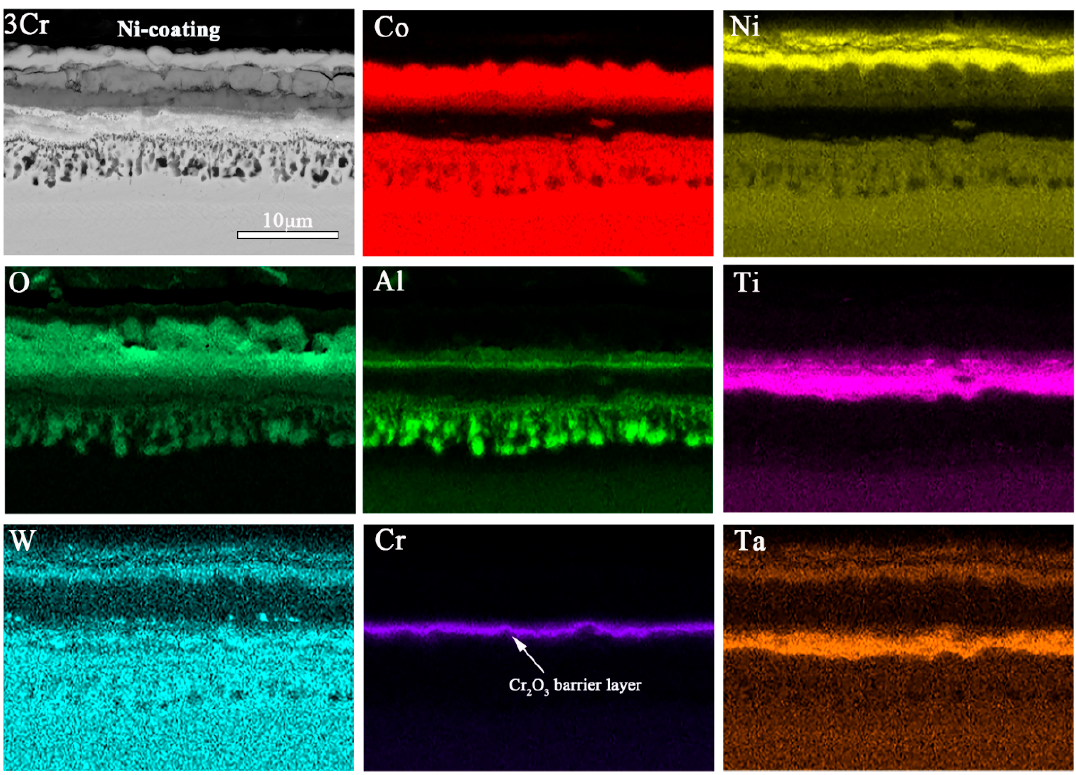
Figure 7. SEM micrographs and EDS mappings of Co-30Ni-10Al-4W-4Ti-2Ta-1Cr alloy oxidized at 900 °C for 100 h.